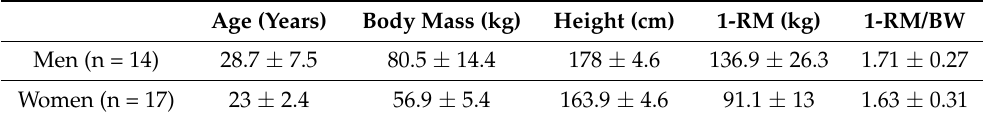
Table 1. Anthropometric characteristics and strength levels (mean ± SD) of the participants (n = 31).